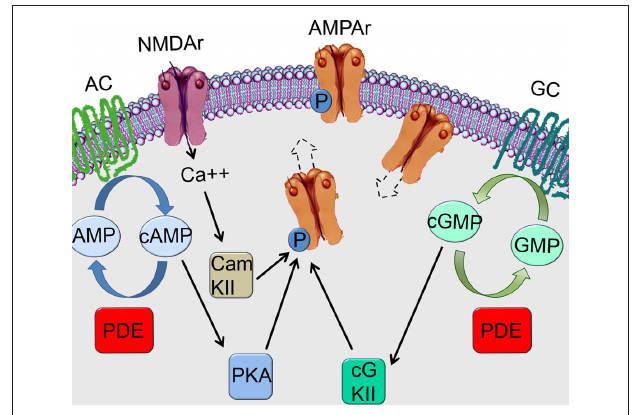
FiGure 2 | inhibition of phosphodiesterase type 1 may lead to phosphorylation of AMPA receptors and its incorporation to the synapse. AC, adenyl cyclase; GC, guanylate